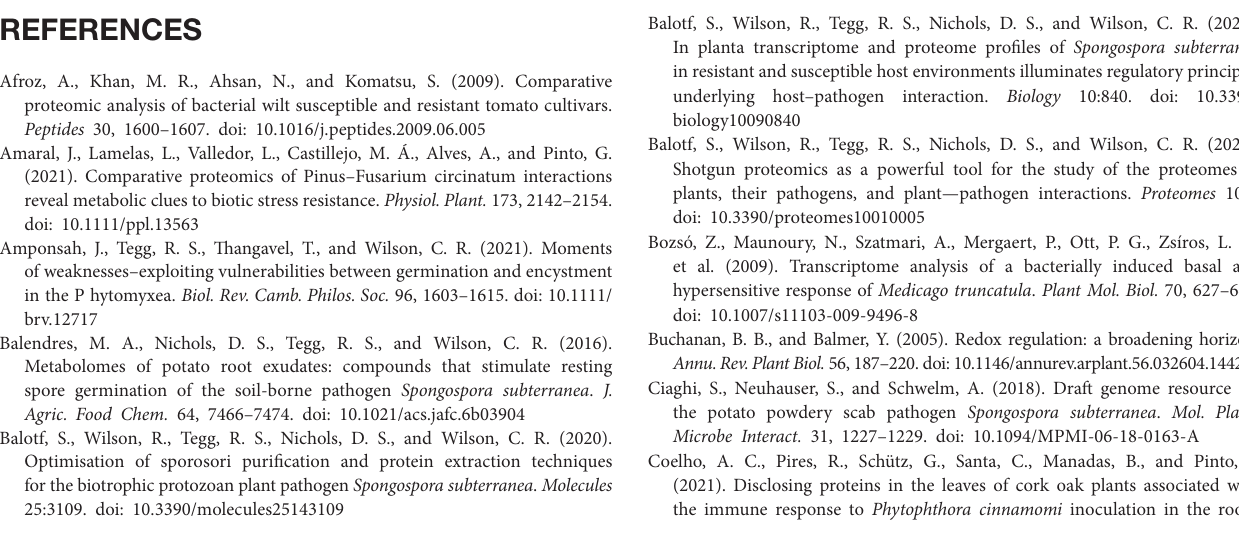
Supplementary Table S3 | Complete list of identified and significantly changed phosphoproteins. Supplementary Data Sheet 1 | Supplementary data legends and